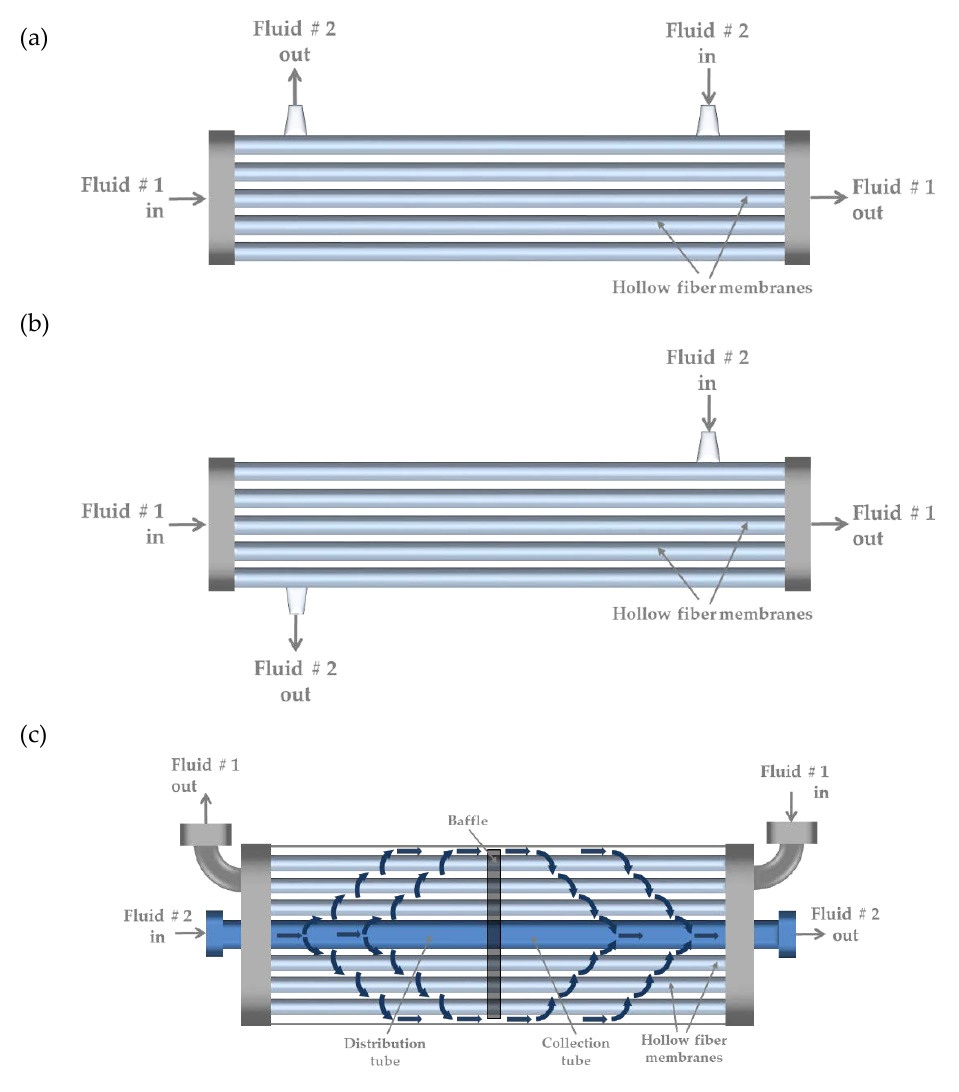
Figure 2. Schemes of the hollow-fiber membrane contactor (HFMC) modules (3M-LiquiCel TM ) assayed in this study. ( a ) 1.7 × 5.5 Mini Module. ( b ) 1.7 × 10 Mini Module. ( c ) 2.5 × 8 Extra Flow Module. Fluid 1 and Fluid 2 correspond to the absorption and feed solution, respectively.